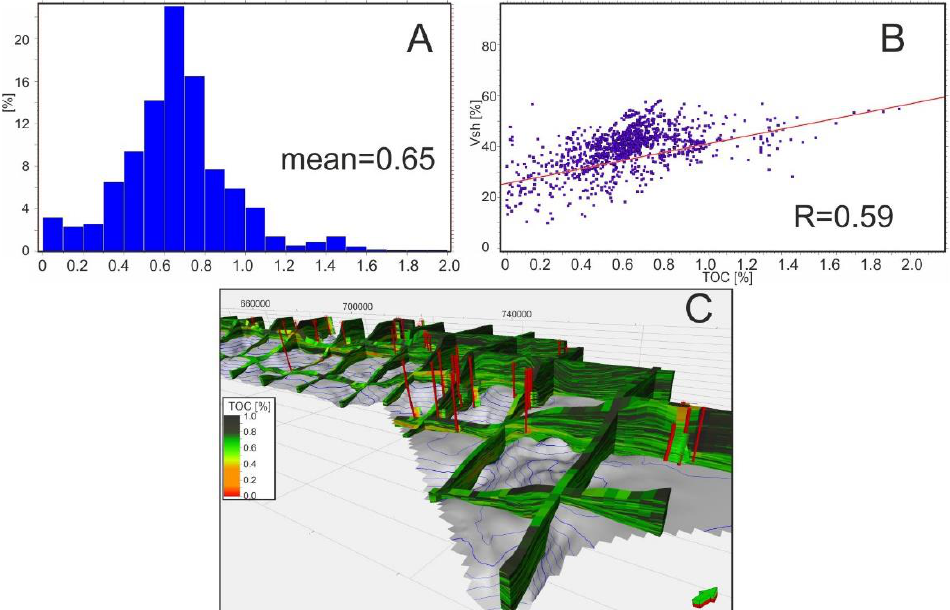
Figure 7. Results of total organic carbon (TOC) modeling: ( A ) Present-day TOC values based on laboratory measurements in 59 wells; ( B) volume of shale (Vsh) vs. TOC correlation (borehole data); ( C ) resulting model of initial TOC values transformed from present-day TOC distribution.